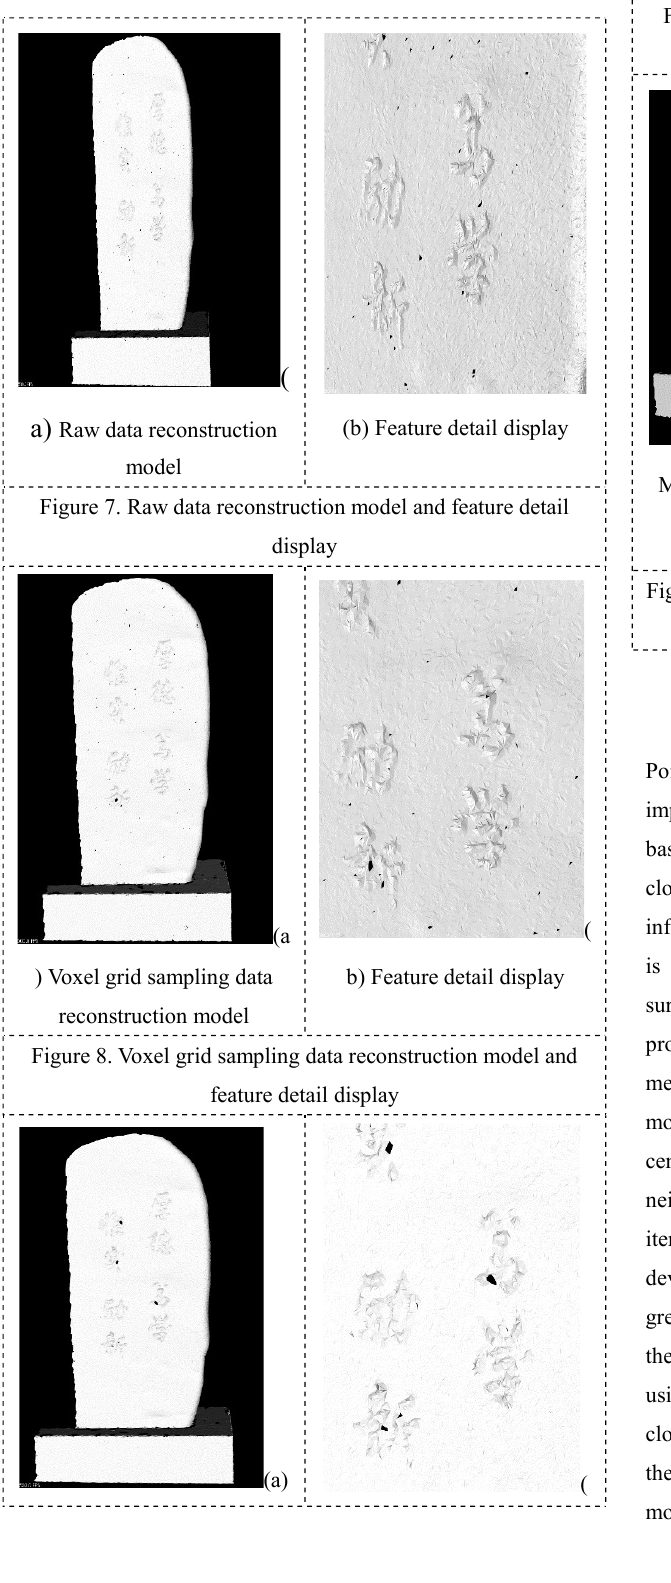
Figure 9. Uniformly sampled data reconstruction model and